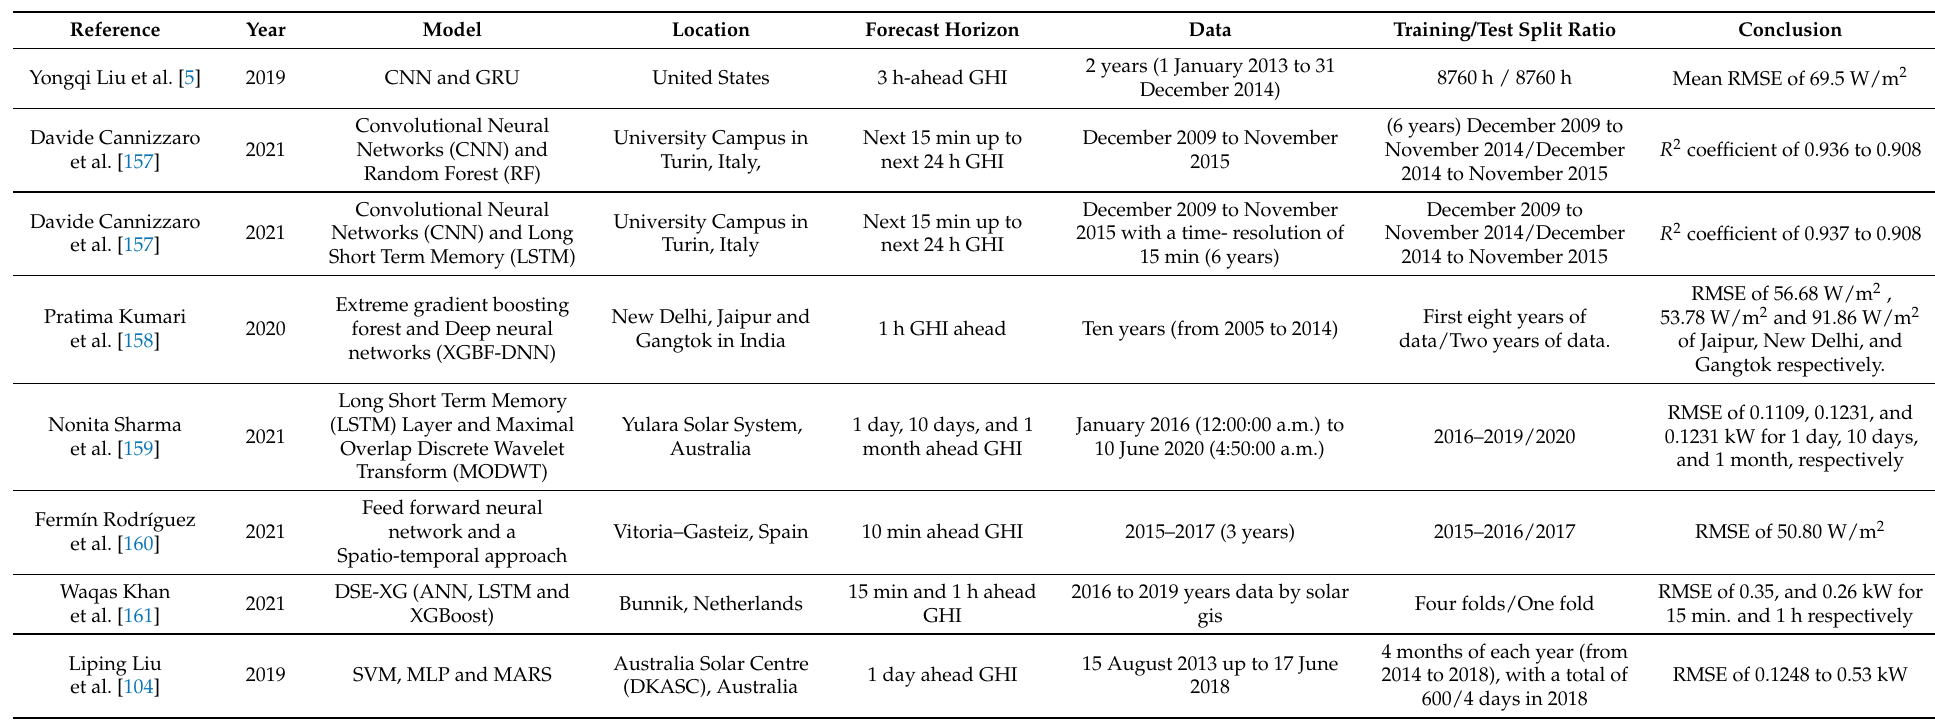
Table 11. Summary of ensemble learning